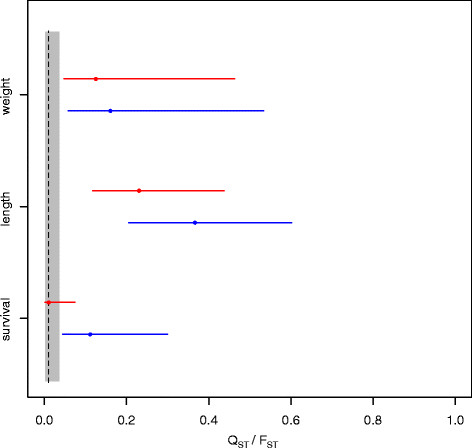
Quantitative trait and neutral marker differentiation of stickleback populations at different temperature treatments. The grey box represents the distribution range of global FST estimates. Blue lines represent 95% confidence intervals of QST values for all phenotypic traits at 17°C, while red lines represent 21°C. Dots indicate position of highest densities of posterior distributions. All data were used for weight and length; only data from infected fish were used for survival.